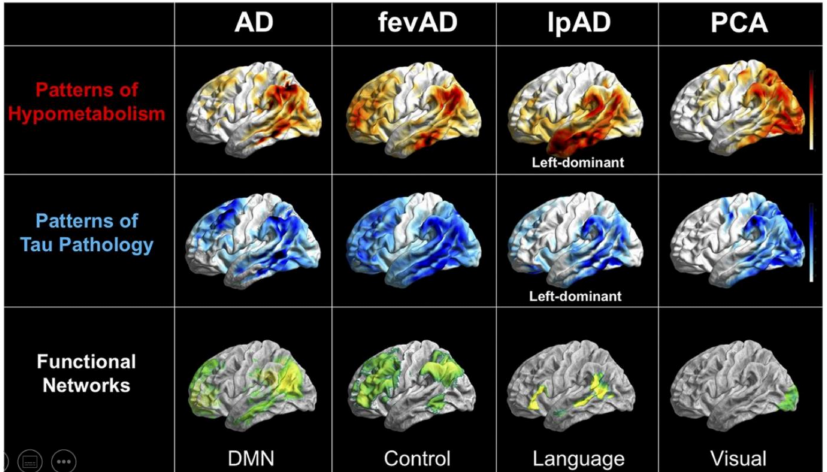
Figure 3. Conceptual depiction of a partial correspondence between hypometabolism (FDG PET), tau PET and functional networks in typical AD ( left ) and three subtypes, frontal-executive variant AD (fevAD), logopenic progressive aphasia (lpAD) and PCA. This figure was originally published in JNM [153]. Reproduced with permission and courtesy of Merle Hoenig, University of Cologne,